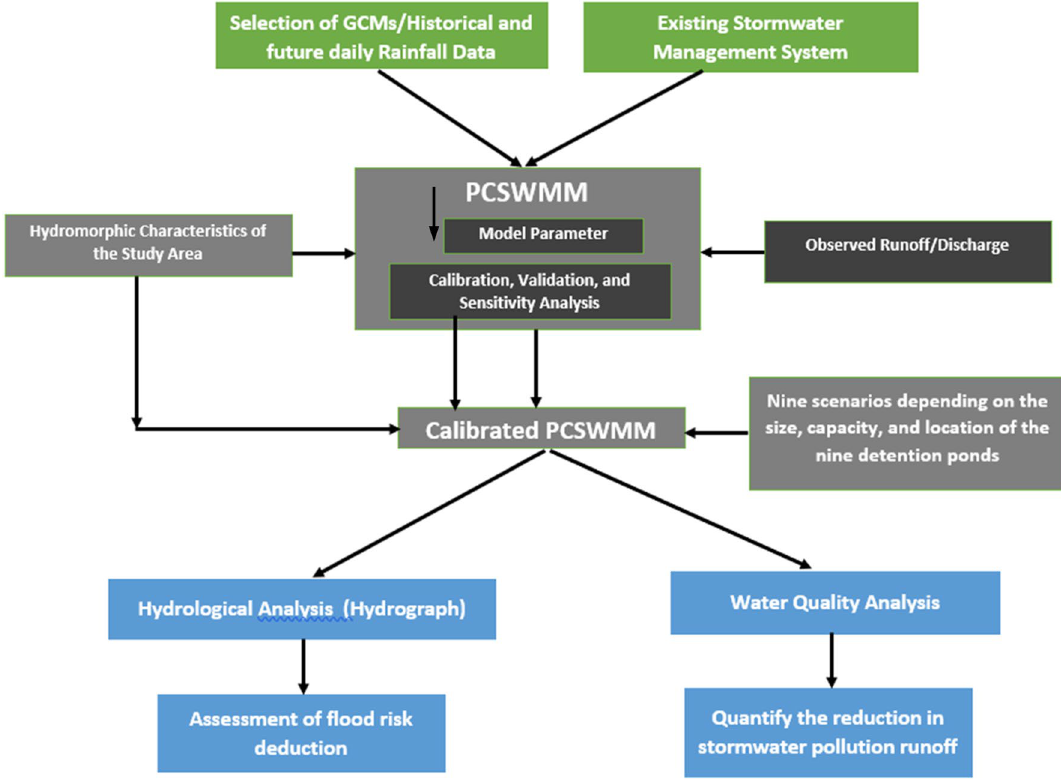
Figure 4. Flowchart showing the integrated framework of methodology.